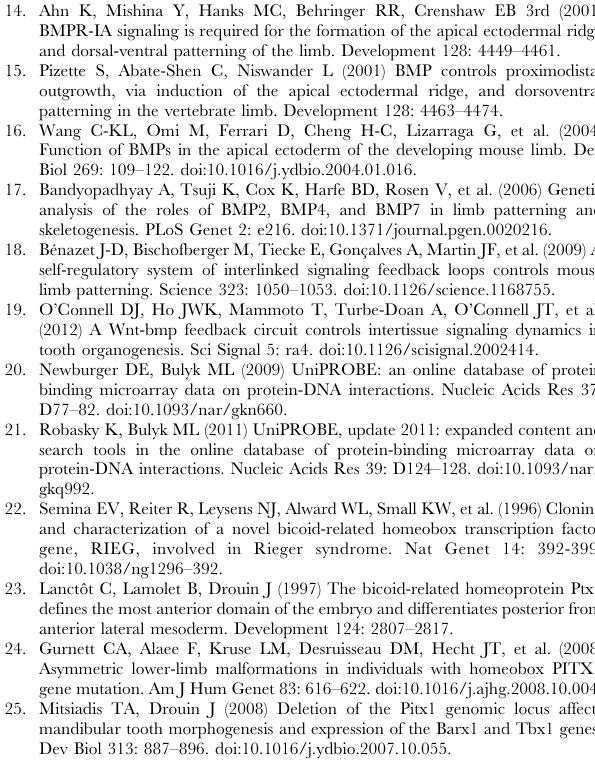
Table S1 Families of Transcription Factors (TFs) with their InterPro (IPR) DNA binding domain annotation number that have potential binding sequences in the minimal Bmp4 enhancer. Transcription factors families with binding sites (BS) in the minimal Bmp4 enhancer in . 75% and . 90% of aligned vertebrates are